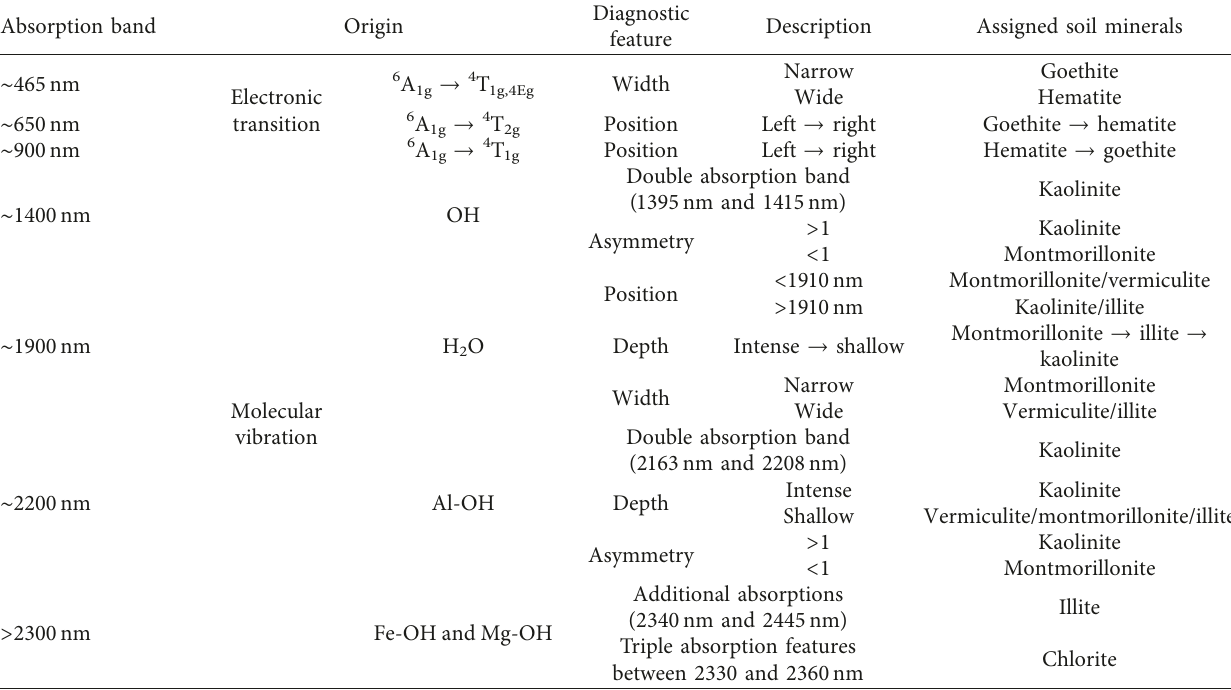
Table 1: Spectral features of some predominant soil minerals.